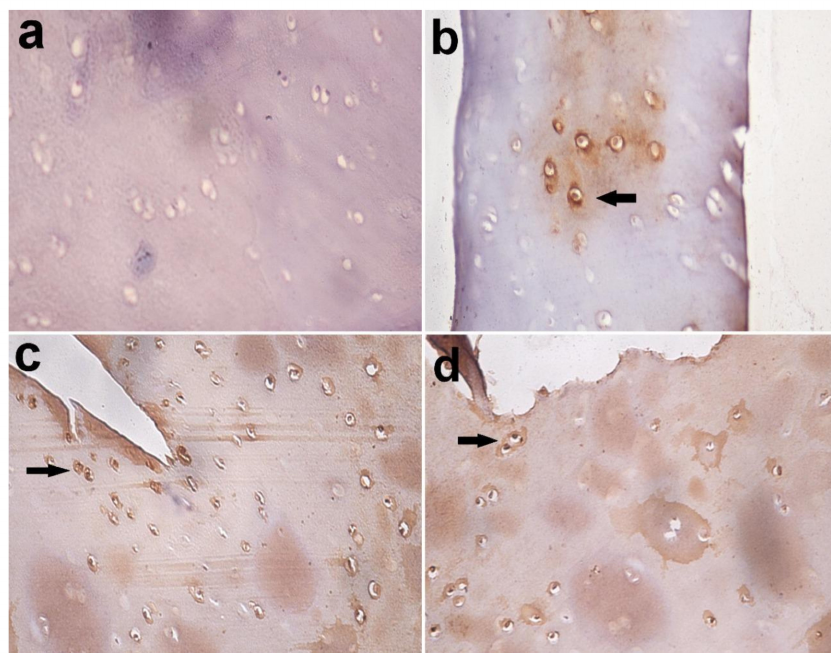
Figure 10. Immunohistochemical staining of Caspase-3 in articular cartilage, equine. ( a ) Caspase-3 negative chondrocytes in control group; ( b ) few Caspase-3 positive chondrocytes in the MIA-injected group after 3 months (arrow); ( c ) many Caspase-3 positive chondrocytes in the MIA-injected group after 5 months; ( d ) and in MIA-injected group after 7 months (arrow). Immuno-peroxidase stain X 400.